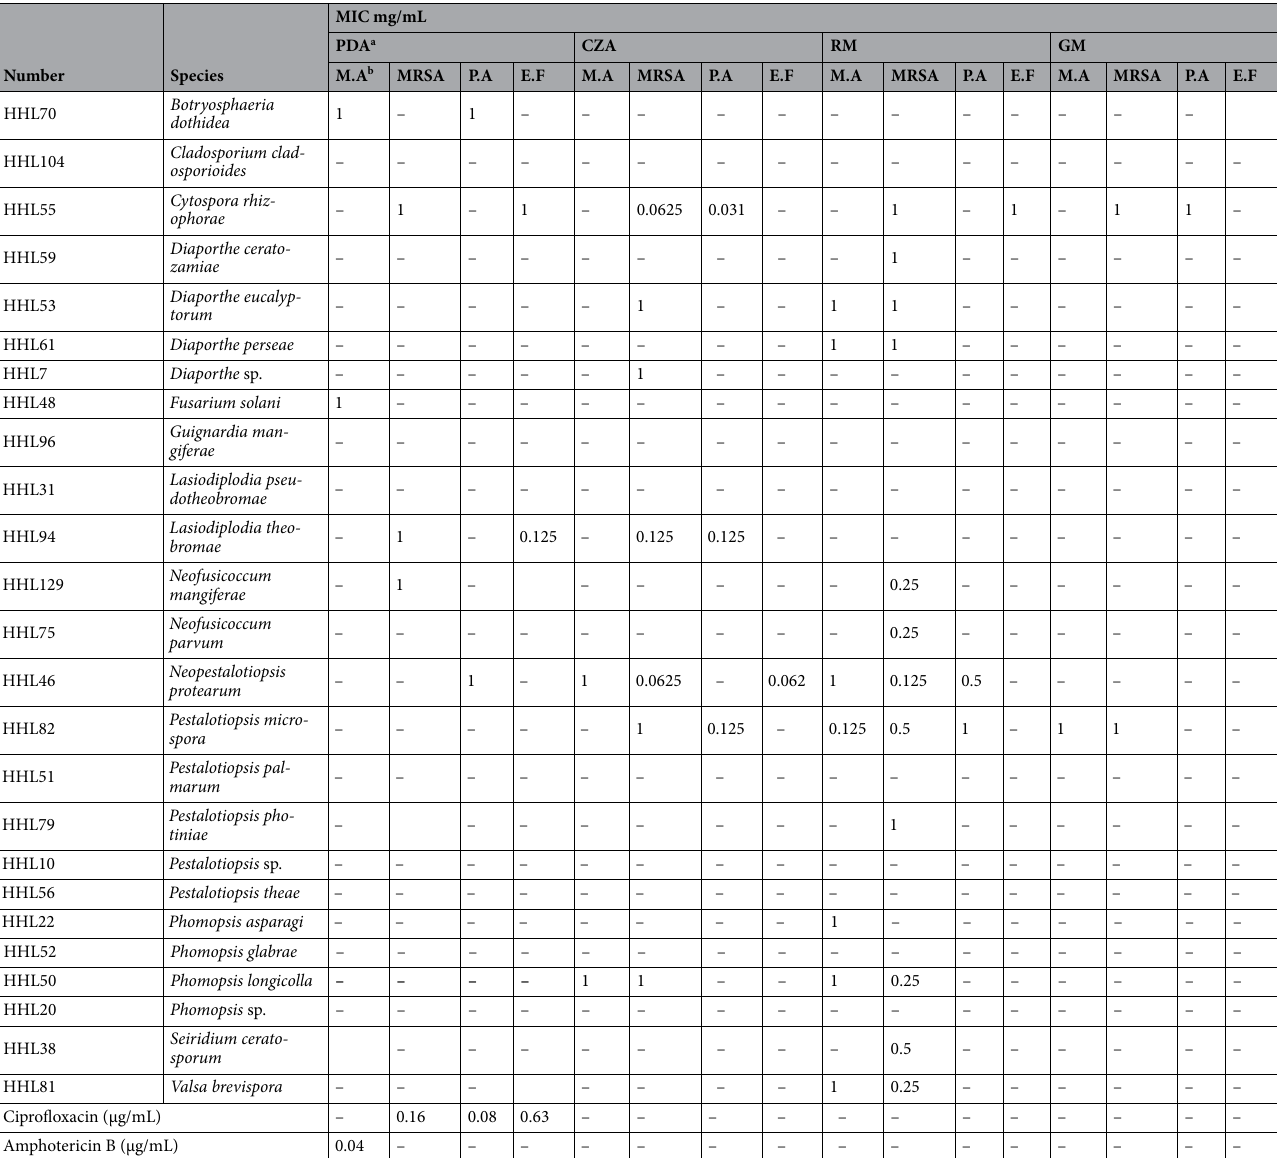
Table 1. Antimicrobial acticity of the endophytic fungi from R. stylosa. a Strains were cultivated on four different medium, which were Dextrose Agar (PDA), Czapek’s Agar (CZA), Rice Medium (RM) and Grain Medium (GM) from R. stylosa. b Antimicrobial activites were tested against Gram-negative [ Pseudomons adaceae (PA)], Gram-positive [ Enterococcus faecalis (EF), Methicillin-resistant Staphylococcus aureus (MRSA)] bacteria and fungi [ Monilia albican